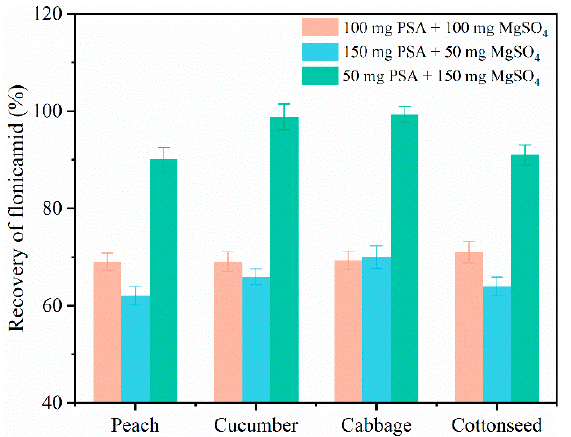
Figure 1. Effect of various purification combination materials on the recovery rate of flonicamid in four crops. four